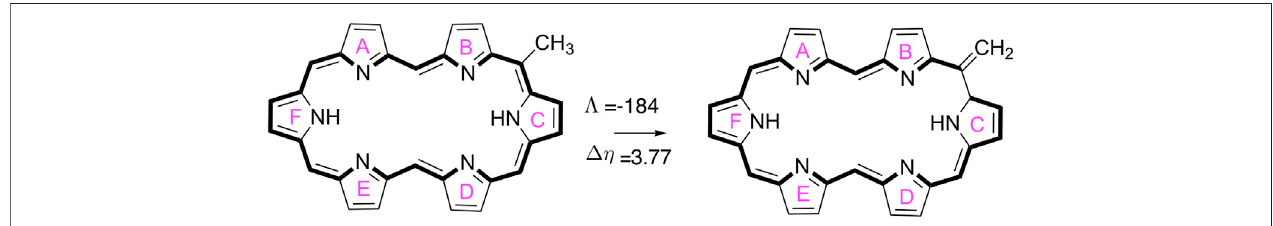
FIGURE 2 | A schematic overview of the isomerization reaction used to evaluate the magnetic susceptibility exaltation ( Λ in ppm cgs) and relative hardness ( Δ η in kcal mol − 1 ) for the 26D macrocycle.